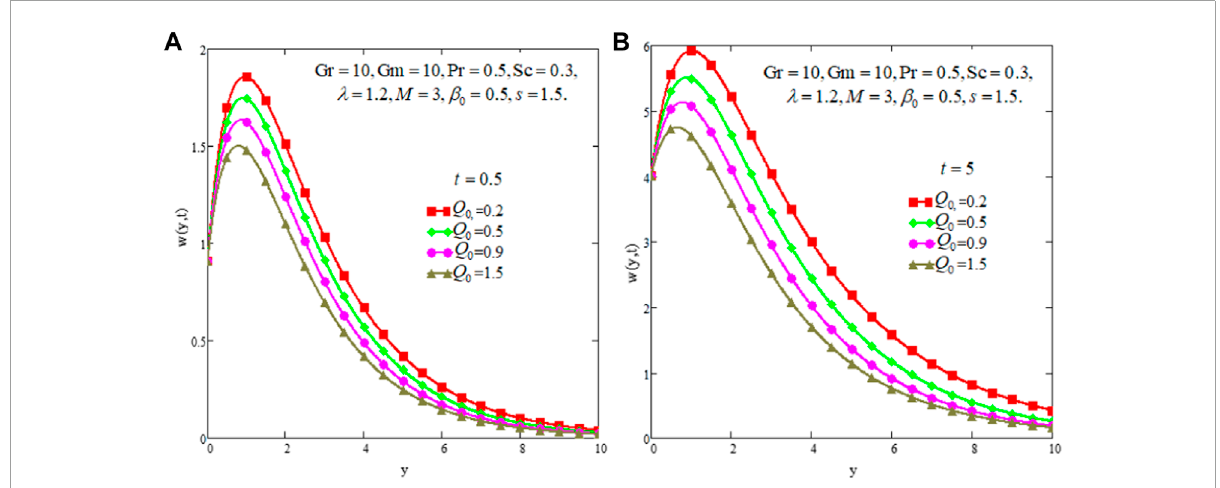
FIGURE 6 Velocity due to Q 0 for small time (A) and for large time (B) .